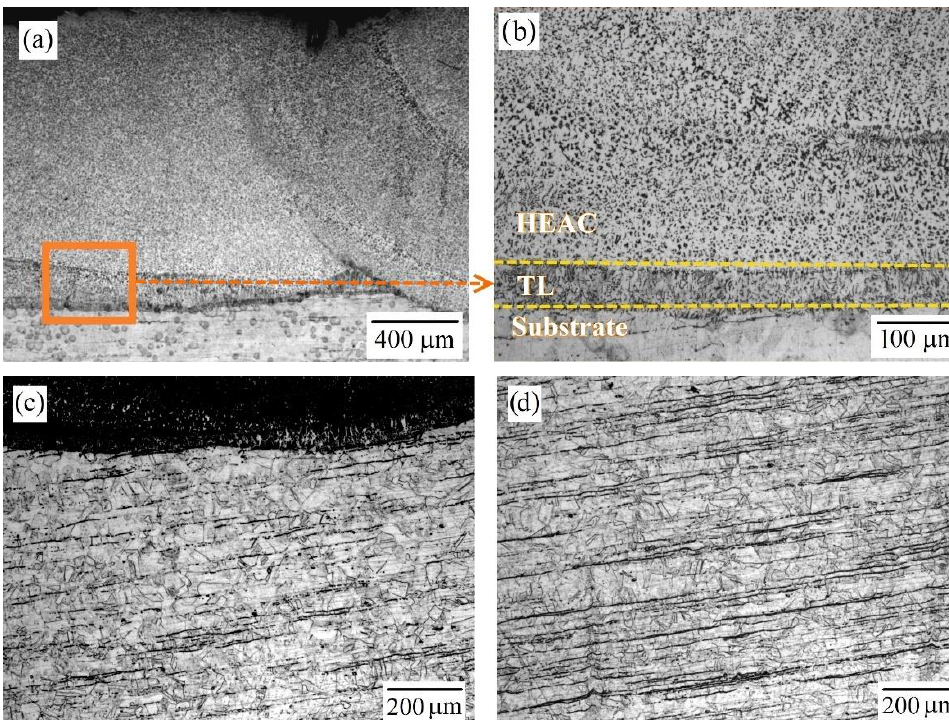
Figure 2. The microstructure after etching according to optical microscopy: ( a ) general view; ( b ) the fusion area of the coating material with the substrate material; ( c ) substrate layer bordering the coating; ( d ) microstructure in the substrate body. TL — transition layer.